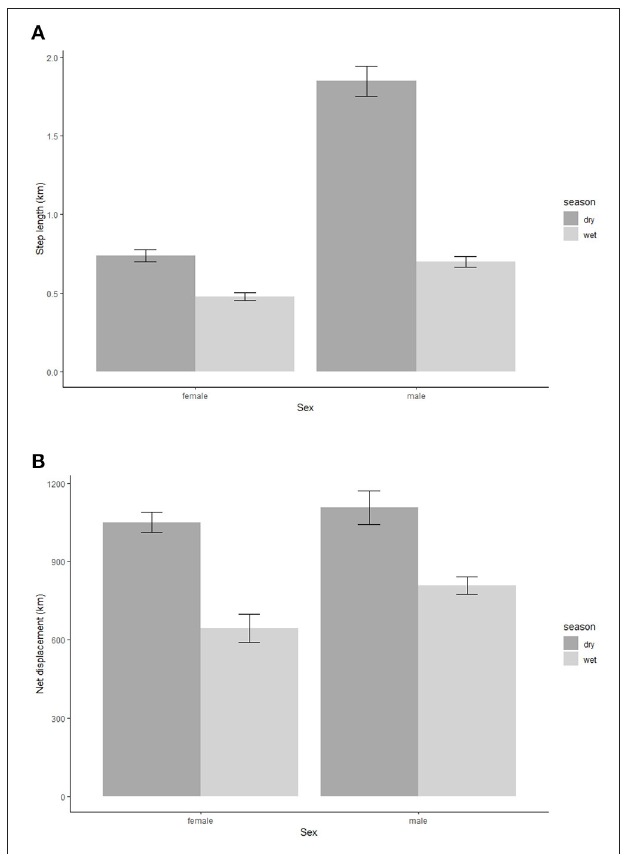
FIGURE 2 | Step length (A) and squared net displacement distances (B) for the female and the male elephants movement paths in the wet (black bars) and the dry (gray bars)